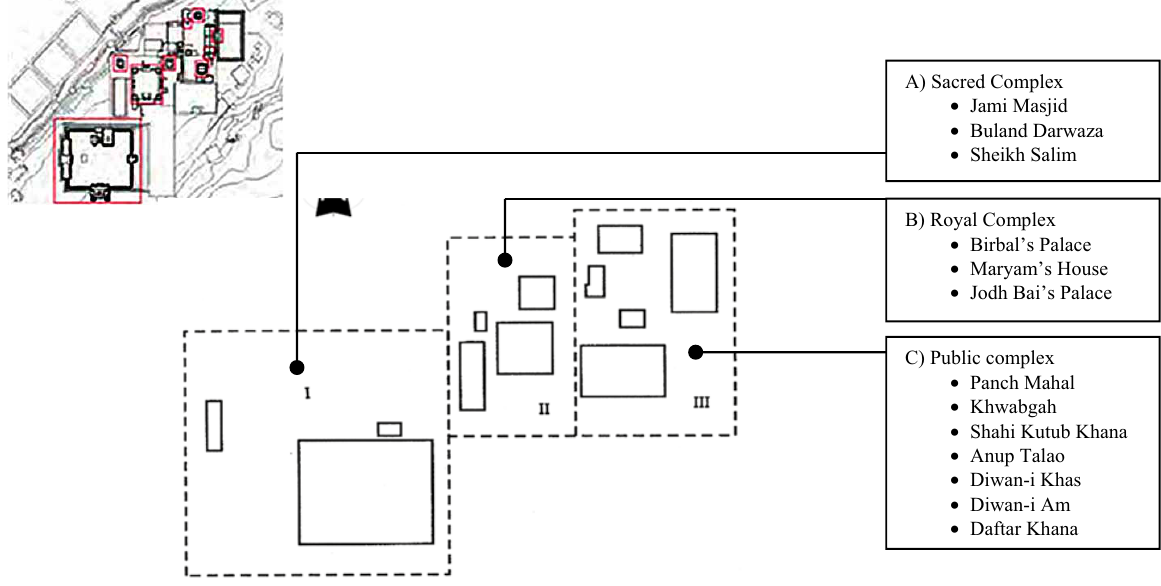
fig. 3a. The urban layout of fatehpur Sikri demonstrating the overlapping orthogonal spaces and “order” of its urban layout with a thumbnail showing key overlapping spaces with key monuments located on key points on intersections of the squares (Shaukat et al. 2014)